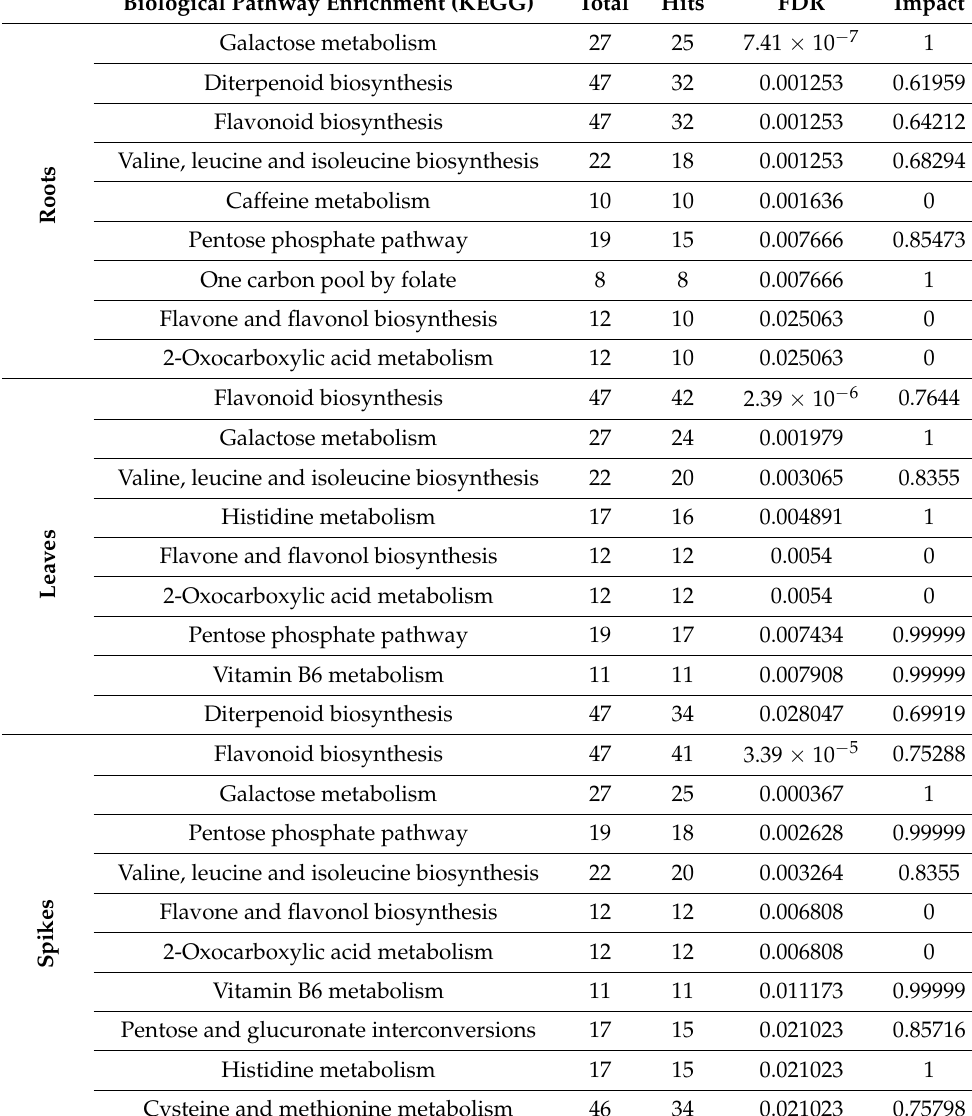
Table 2. Metabolic pathways discriminating Bd21 and Bd3-1 lines in particular organs selected based on pathway enrichment analysis performed with MS signals representing differentially accumulating metabolites (DAMs). KEGG—Kyoto Encyclopedia of Genes and Genomes [37]; total—number of compounds included in biological pathway in the database; hits—number of compounds matched in our analysis; FDR—false discovery rate; impact—pathway impact value related to the number of links occurred upon a node in pathway topology graph. Full sets of data including other pathways as well as lists of annotated metabolites are available as Supplementary Table S2 (roots), Supplementary Table S3 (leaves) and Supplementary Table S4